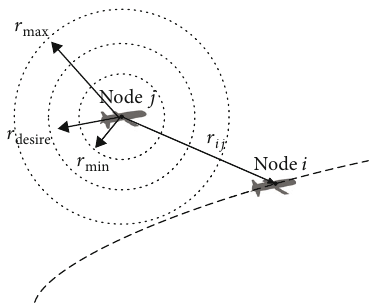
Figure 7: UAV formation collision avoidance